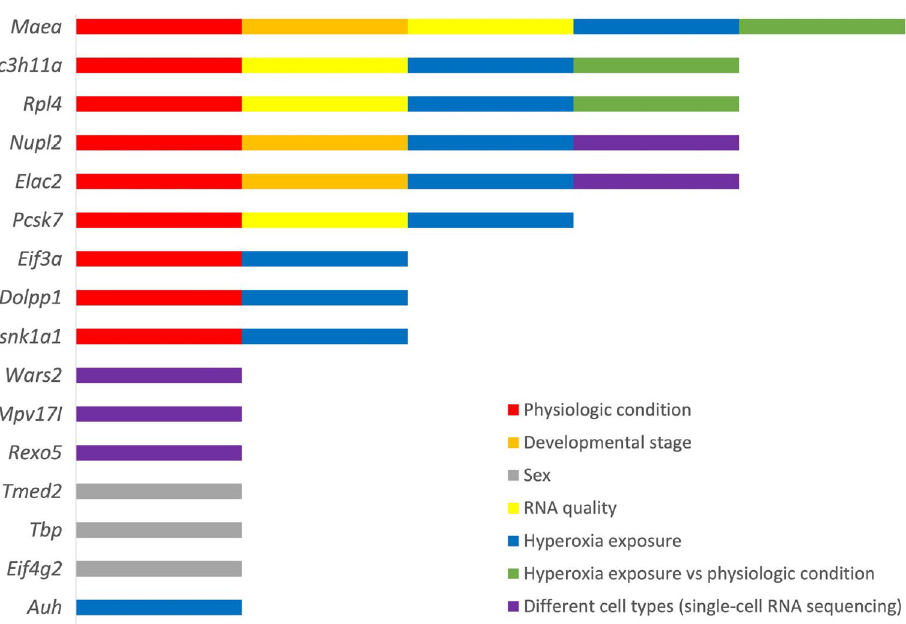
Figure 4. The reliable reference genes with regard to the analytical approaches. 16 out of 23 reference gene candidates that were identified in at least one analytical approach (colored bars) as a reliable reference gene are presented. Maea was most commonly identified as stably expressed gene among the different analytical approaches. For detailed information about experimental conditions of the analytical approaches see the